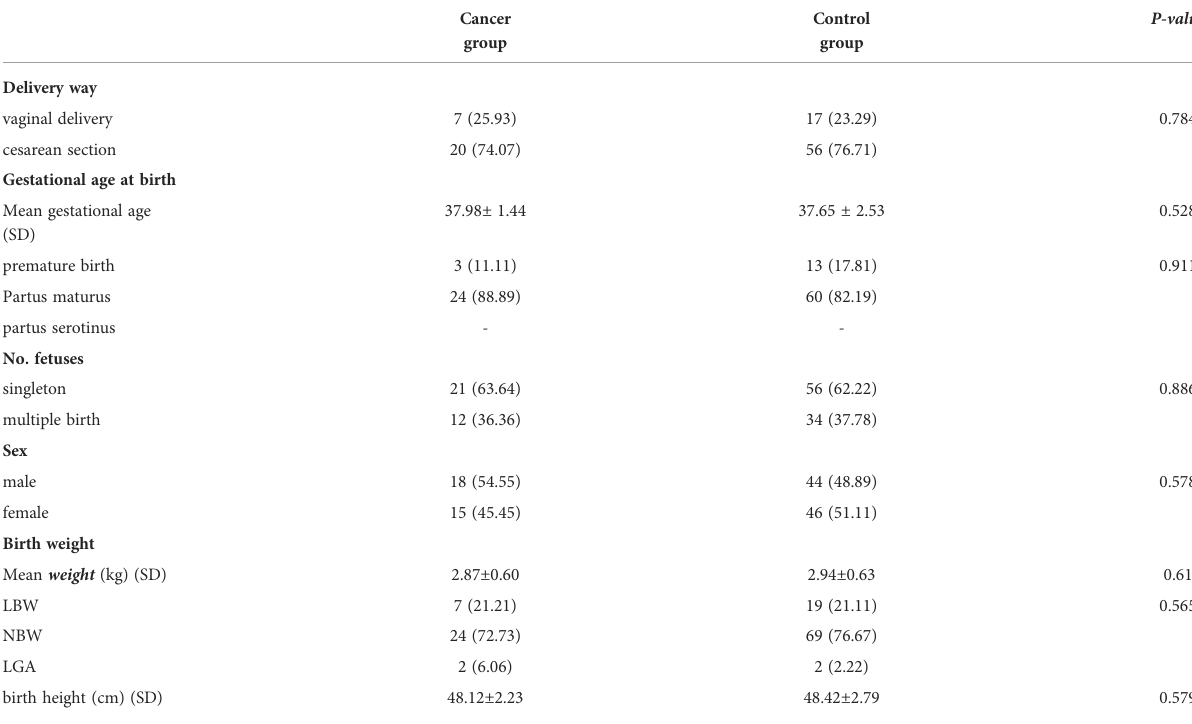
TABLE 6 Childbirth outcomes.